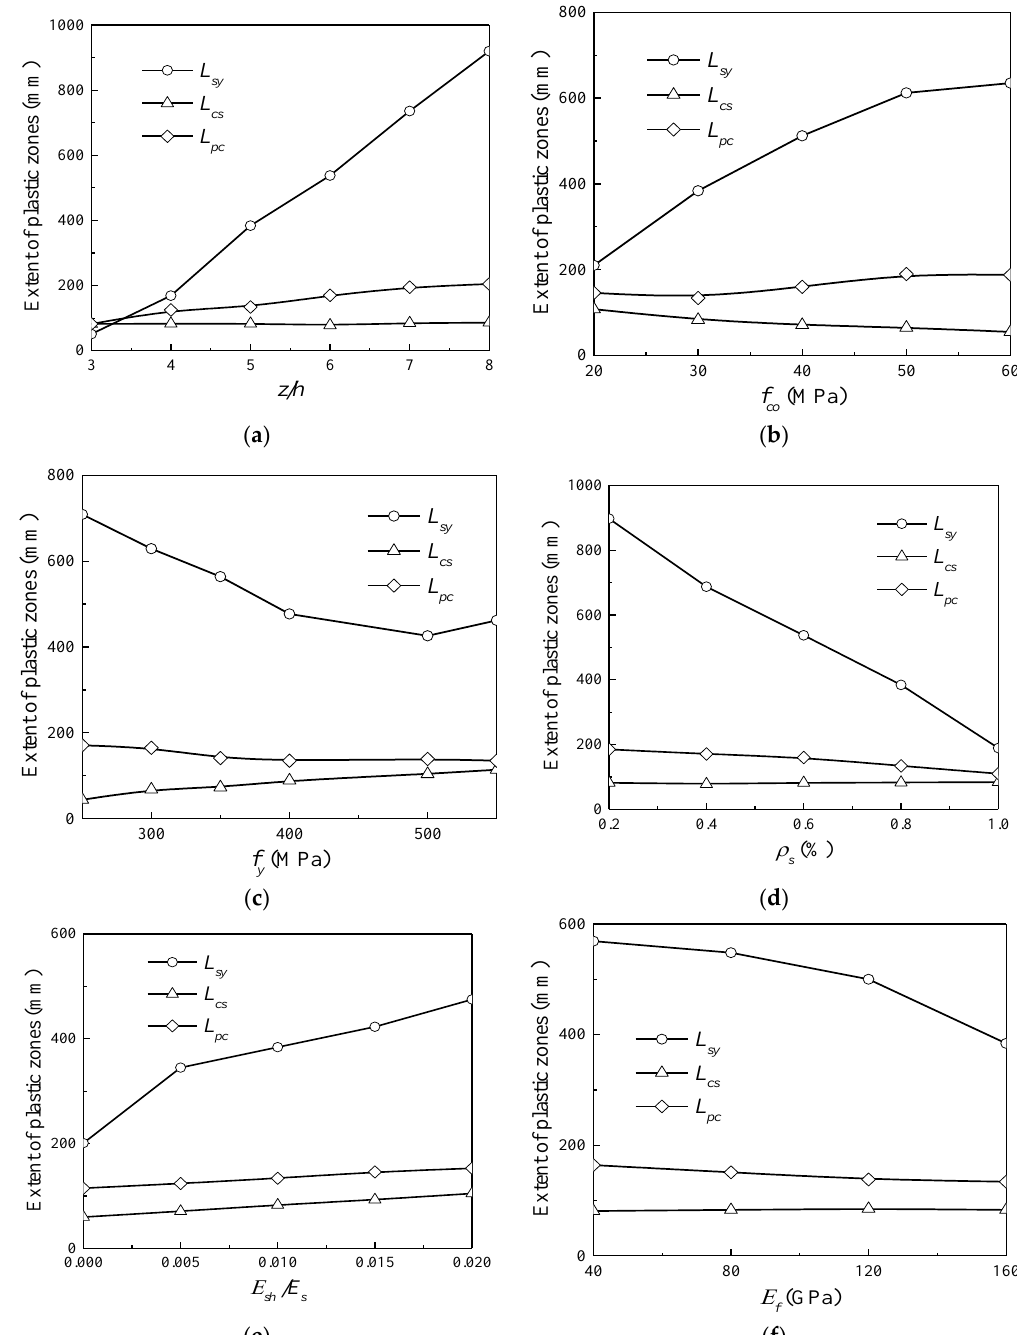
Figure 10. Variation of plastic hinge zones: ( a ) effect of aspect ratio; ( b ) effect of compressive strength of concrete; ( c ) effect of yield strength of steel reinforcement; ( d ) effect of steel reinforcement ratio; ( e ) effect of hardening modulus of steel reinforcement; ( f ) elastic modulus of fibre-reinforced polymer (FRP) reinforcement.